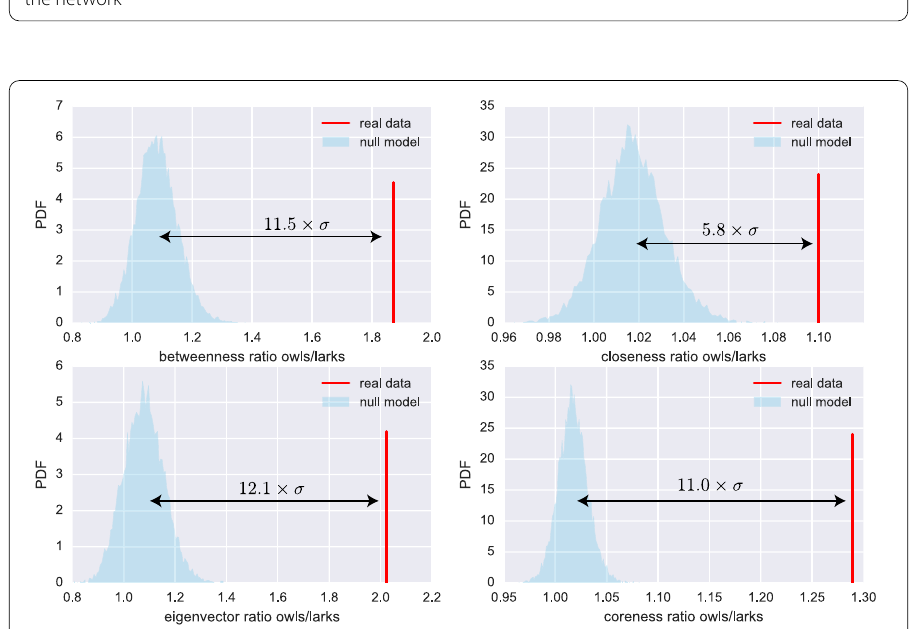
Figure 3 Chronotypes and centrality measures. Chronotypes are associated with network centrality such that owls are on average more central. Panels ( A )–( D ): network centrality measures (betweenness centrality, closeness centrality, eigenvector centrality, and core number) for the three chronotypes. In all cases, values for the owl chronotype are the highest. Panel ( E ): a network visualization of the social network of participants. Individuals of the owl (lark) chronotype are displayed as blue (red). The rest are gray. For blue and red nodes, the size is determined by core number. Nodes of the owl chronotype are more frequent in the central core